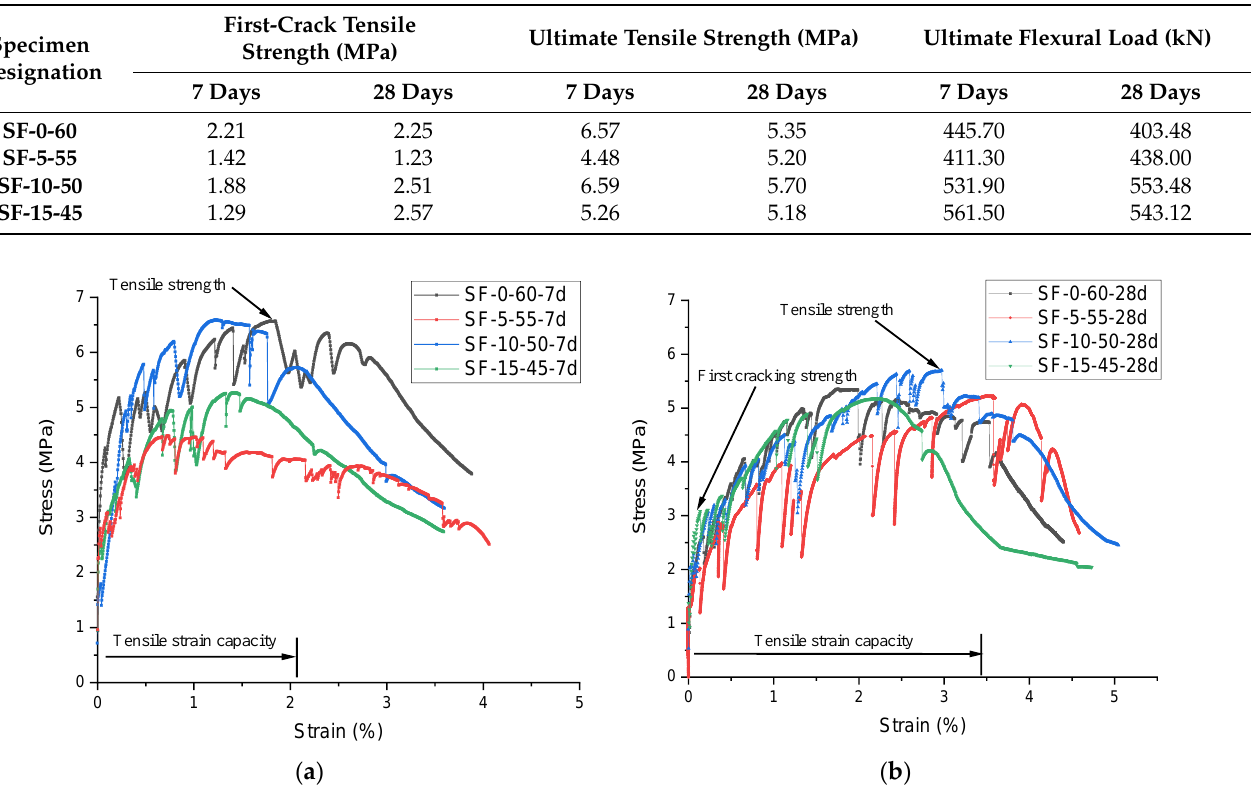
Figure 5. Stress – strain curves of slag/fly-ash-based ECC mixtures: ( a ) 7 days ( b ) 28 days. Curves represent the average of measurements of three separate specimens.